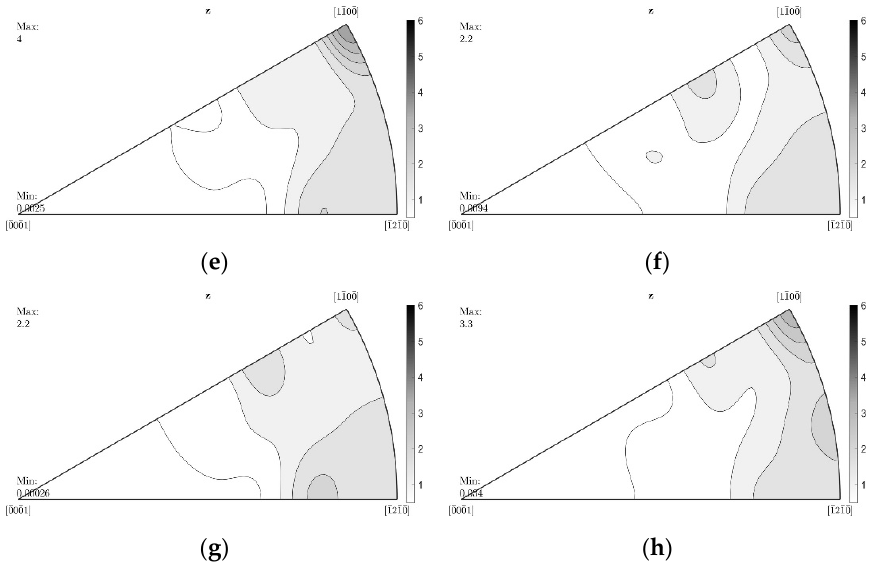
Figure 4. Inverse pole figures in extrusion direction from extruded round bars of AM60 ( a , c , e , g ) and AM60 with 1 wt.% AlN ( b , d , f , h ) with different extrusion speeds, left: <00.1>, bottom right: <10.0>, top right: <11.0>.